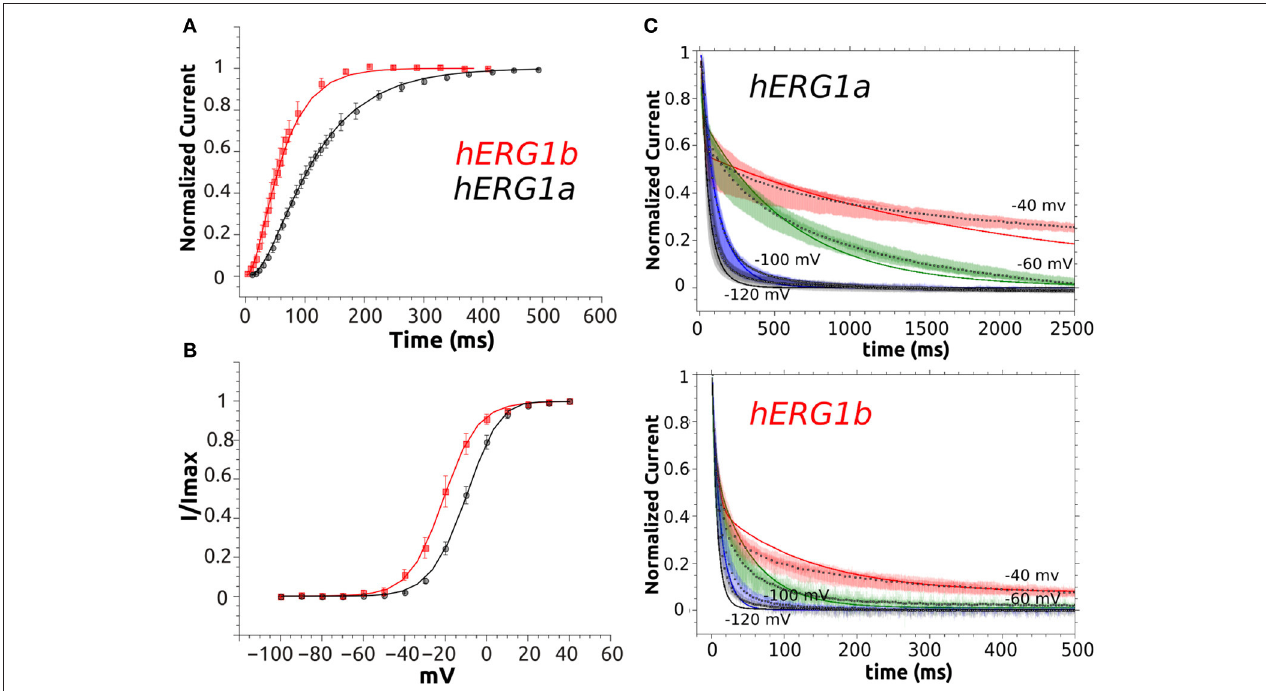
FIGURE 7 | M-model 2 fit to experimental data. (A) Activation curve of a-isoform and b-isoform. (B) Steady State Activation curve for both isoforms. (C) Simulated deactivation curves at − 120, − 100, − 60, and − 40mV. Simulated data is shown as solid lines and symbols are used for experimental time course data (average, n = 10). Superimposed raw time course data ( n = 10) is shown in the background for deactivation at each